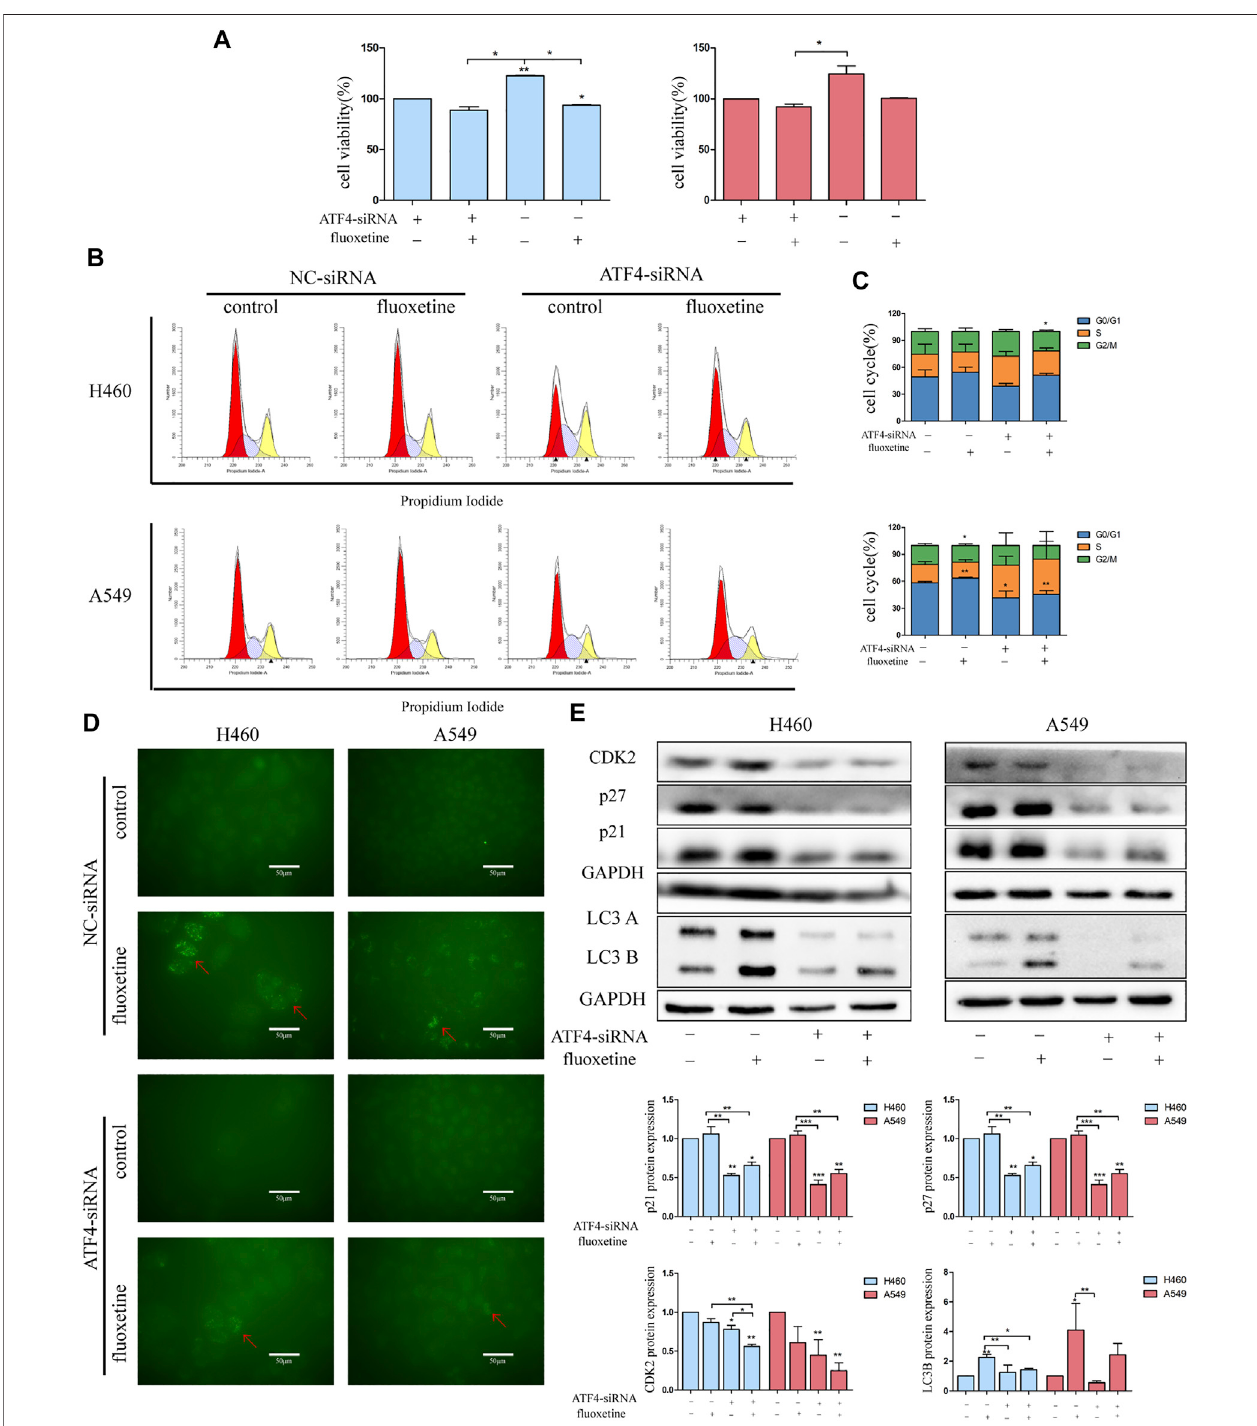
FIGURE 7 | Fluoxetine-induced anticancer effect through the ATF4-AKT-mTOR signaling pathway (A) the cell viability in lung cancer cells transfected with ATF4 siRNA for48 hfollowedbyexposure to fl uoxetine (20 μ M)foranother 24 hwasassessed byCCK8. Leftand rightindicateH460cellsandA549cells,respectively. (B,C) The distribution of the cell cycle in lung cancer cells transfected with ATF4 siRNA for 48 h followed by exposure to fl uoxetine (20 μ M) for another 24 h was analyzed by fl ow cytometry. (D) The autophagy in lung cancer cells transfected with ATF4 siRNA for 48 h followed by exposure to fl uoxetine (20 μ M) for another 24 h was observed by immuno fl uorescence of LC3 (green). Scale bars were 50 μ m. (E) The expression of CDK2, p27, p21, and LC3 in lung cancer cells transfected with ATF4 siRNA for 48 h followed by exposure to fl uoxetine (20 μ M) for another 24 h was tested by Western blot. Left and right indicate H460 cells and A549 cells, respectively. The images were collected from different parts of the same gel. Data are presented as mean ± SD; * p < 0.05, ** p < 0.01, *** p < 0.001.